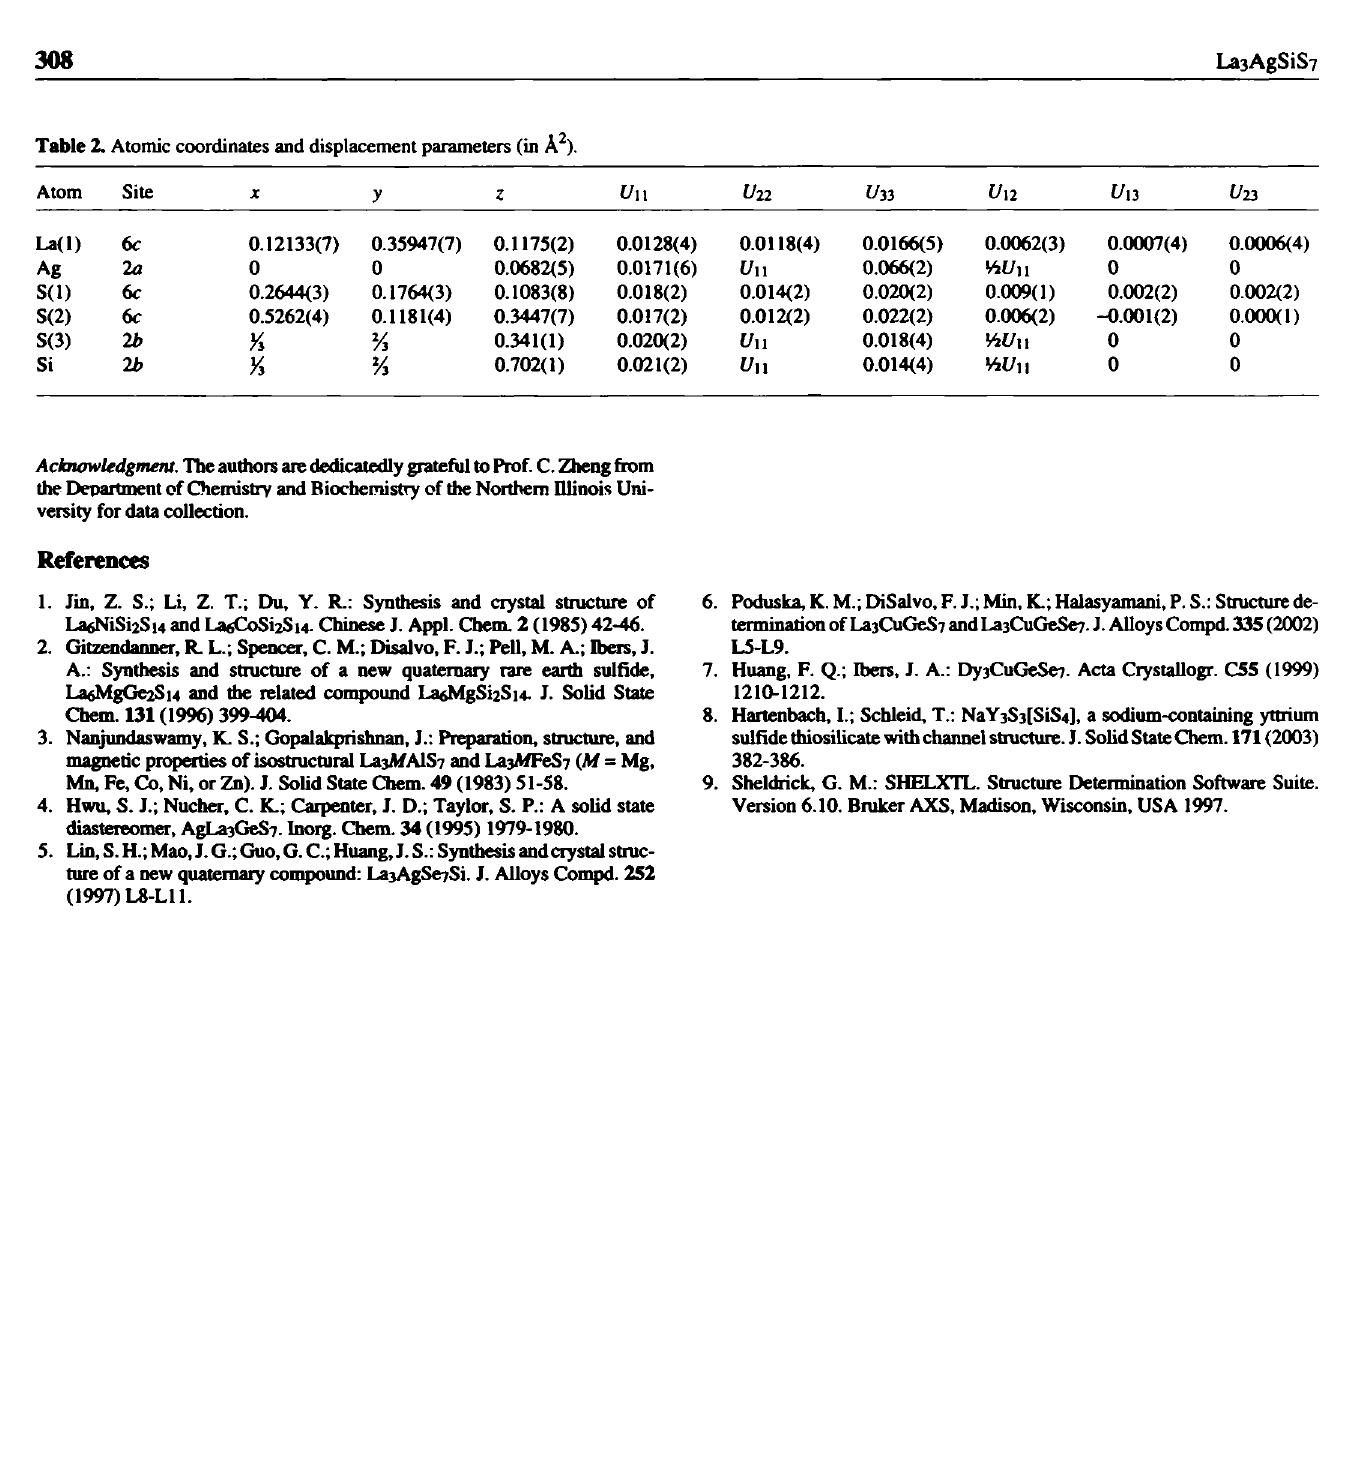
Table 2. Atomic coordinates and displacement parameters (in A 2